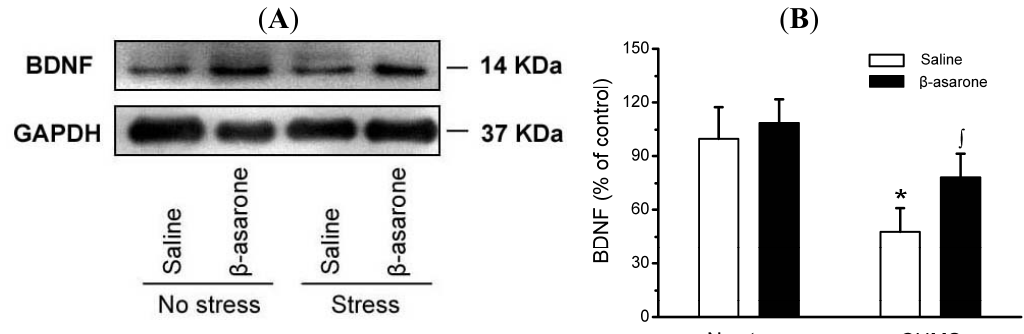
Figure 5. β -Asarone increases BDNF expression in hippocampus of CUMS-exposed rats. Rats were orally treated with β -asarone (25 mg/kg per day) or saline for 28 days while being exposed to CUMS or control conditions. ( A ) BDNF protein levels were determined by immunoblot analysis with antibody against BDNF. GAPDH served as a loading control. A representative immunoblot for BDNF and GAPDH. ( B ) The graph demonstrates the densitometric analysis of BDNF protein expression (normalized to GAPDH). ( C ) Total RNA was isolated from hippocampus using RNAiso reagent and used for cDNA synthesis. The mRNA levels BDNF was detected by real-time PCR and the 2 −ΔΔ Ct method. Data were presented as mean ± S.D., n = 6 per group. * , p < 0.05 compared with no stress/saline animals;  , p < 0.05 compared with CUMS/saline animals (analysis of variance and SNK post hoc